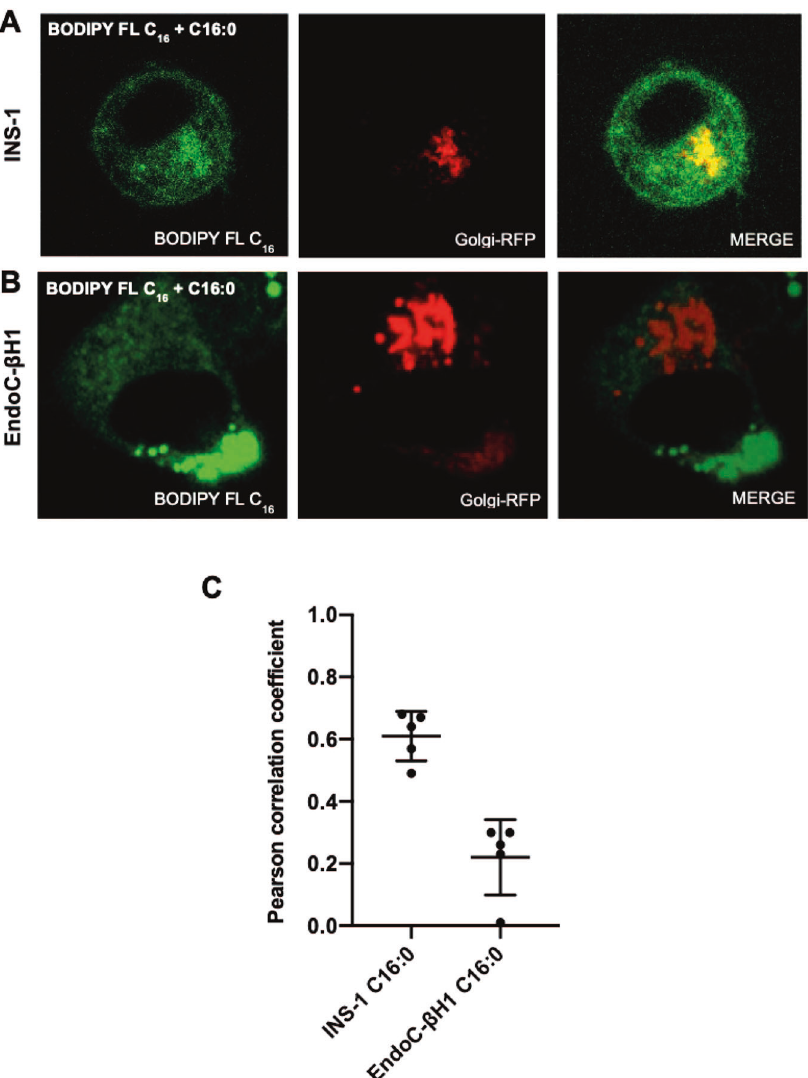
Fig. 4 Palmitate (C16:0) accumulates in the Golgi apparatus of rodent but not human β -cells. The Golgi apparatus of INS-1E ( A ) and EndoC- β H1 ( B ) cells was stained with CellLight Golgi-RFP (red) and exposed to BODIPY FL C included to show co-localisation. C Pearson correlation coef fi cient demonstrating the co-localisation of BODIPY FL C 16 and CellLight Golgi-RFP. Dots represent individual data points. Data are mean + SD ( N = phosphorylation of eIF2 α (Fig. 5A, B), or the expression of CHOP- 10 (Fig. 5C, D), both of which are typically associated with activation of the PERK pathway of ER stress. As expected, tunicamycin, a known inducer of PERK-mediated ER stress, promoted eIF2 α phosphorylation and a signi fi cant rise in CHOP-